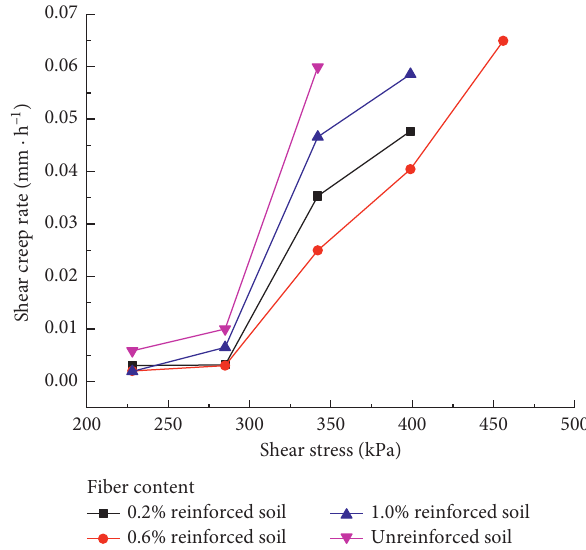
Figure 5: Stress-strain rate curves of soil with different fiber